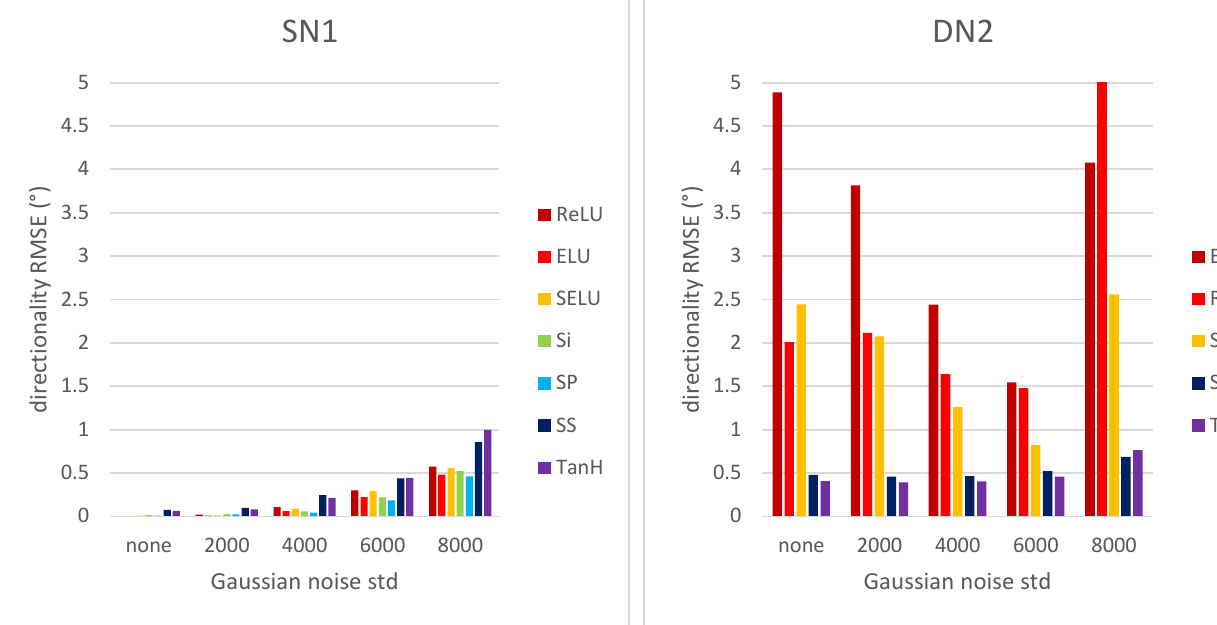
Figure 8. Directionality RMSE for CNNs SN1 and DN2 vs. Gaussian noise standard deviation.